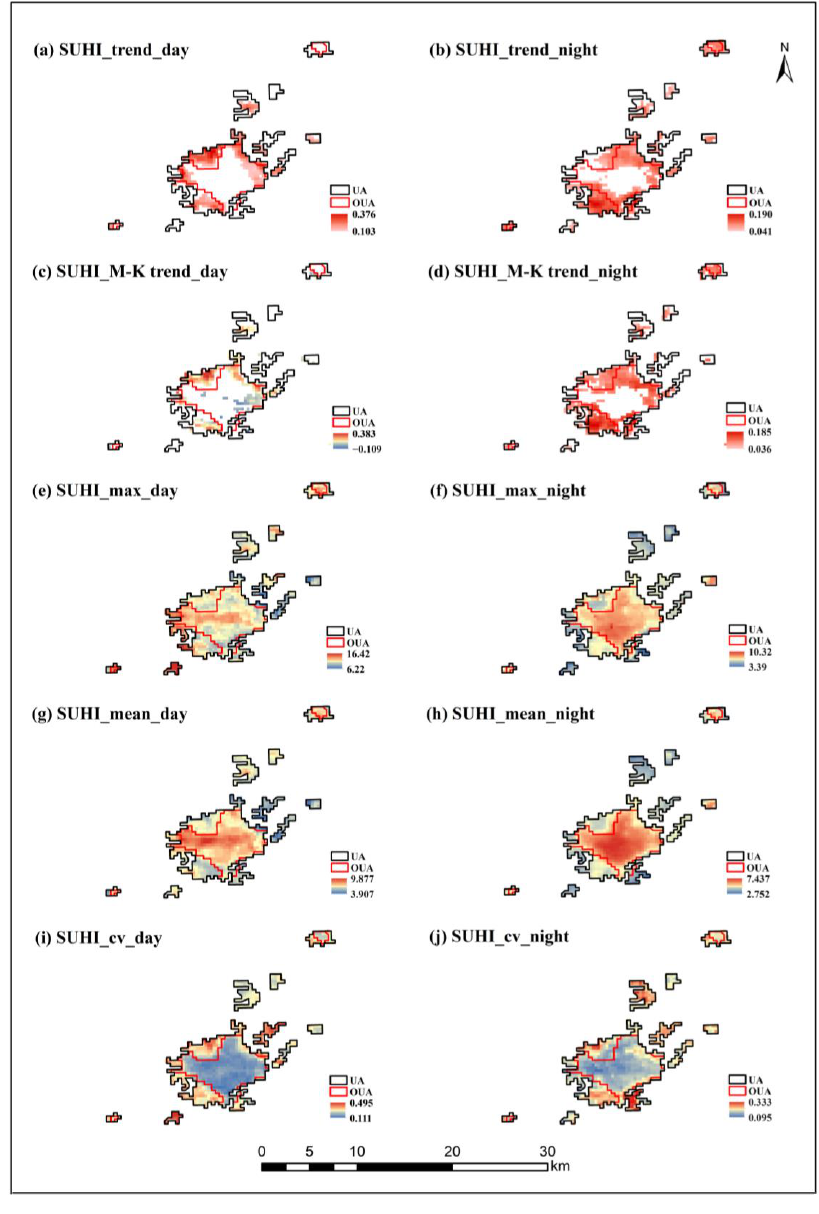
Figure 3. The spatial distribution of SUHI_trend ( a , b ), SUHI_M-K trend ( c , d ), max ( e , f ), mean ( g , h ), and CV ( i,j ) values of the SUHI during daytime and nighttime in urban areas, including the new urban area (NUA) and the old urban area (OUA). The SUHI_trend plots only show the pixels that underwent significant changes, while red indicates a positive trend.